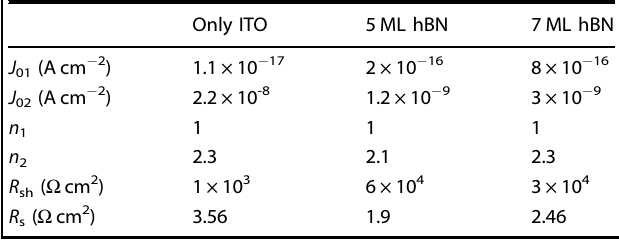
Table 1. Dark IV fi tting parameters for the three types of solar cells investigated in this